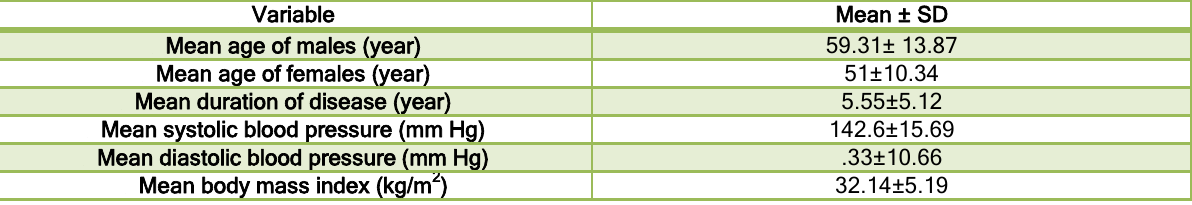
Table 4: Dietary and drug intake life style modification of the studied hypertensive patients (N=219). Dietary and drug intake changes Always